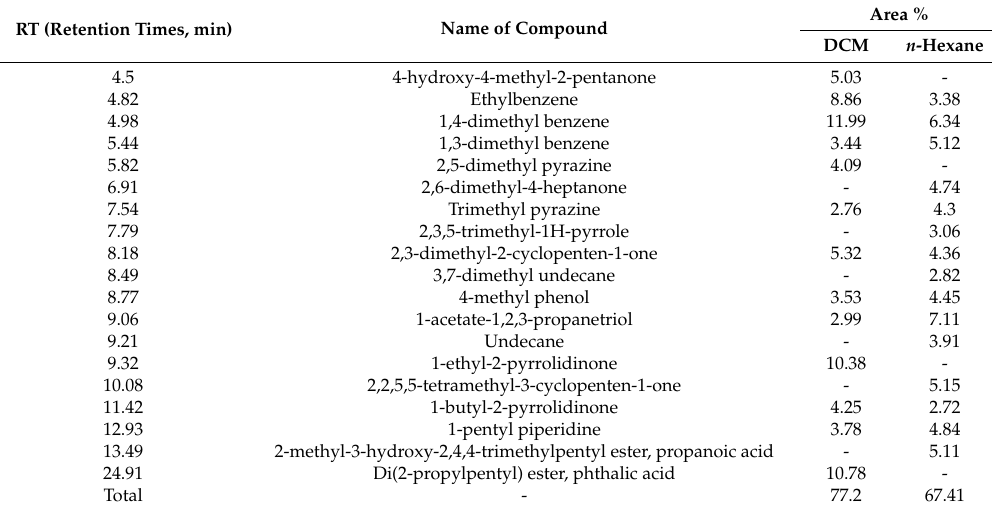
Table 2. Major compounds of recovered bio-oils obtained from HTL (350 ◦ C, 60 min, 2 bar nitrogen atmosphere) using two different extraction solvents (DCM and n -hexane).